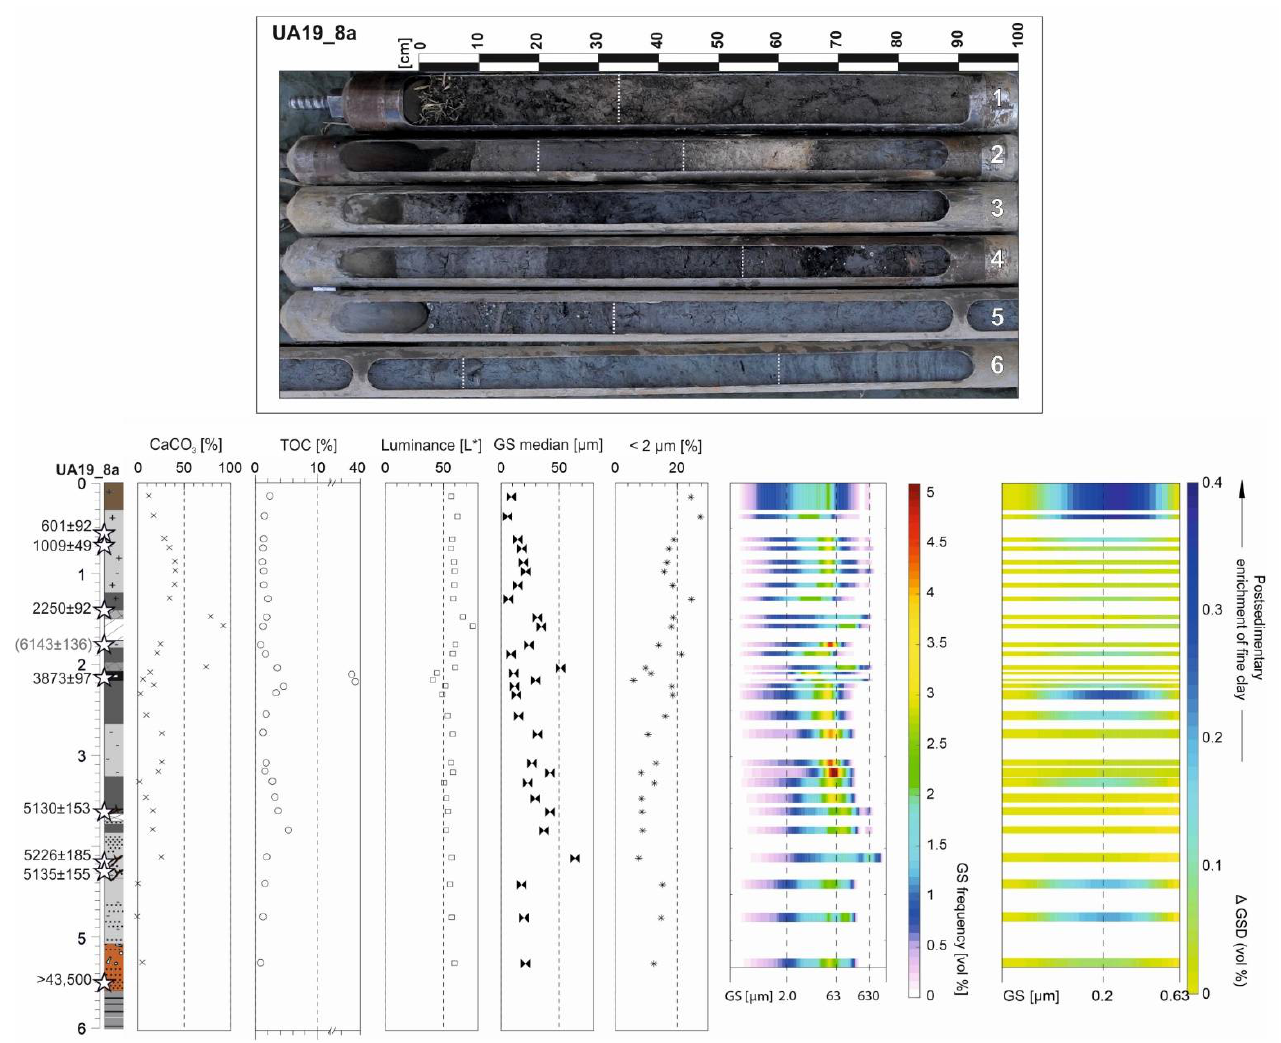
Figure 7. ( Top ) Drilling core UA19_8a shows laminated lake sediments below approx. 5.6 m, covered by fine-grained slope debris (5.08 to 5.6 m). Basal overbank fines were drilled from 4.33 m to 5.08 m overlain by paleochannel infillings (3.55 to 4.33 m) and overbank fines intercalated in “rieth series” deposits (1.45 to 3.55 m). Above this (1.2 to 1.45 m), organic overbank fines were recovered changing upwards to greyish brown overbank fines. The uppermost 0.35 m consists of mixed colluvium with overbank fines. ( Bottom ) Laboratory results obtained for drilling core UA19_8a. The schematic illustration (left of the graphs) refers to Figure 4.